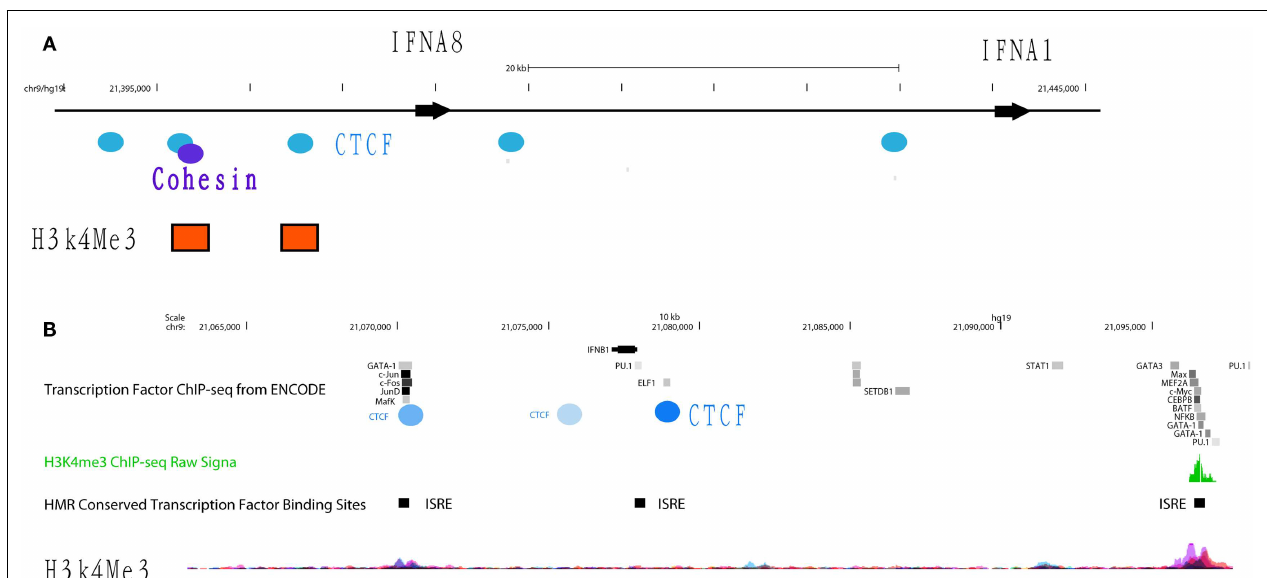
genomic region of IFNB is shown with transcription factor binding sites from the ENCODE database. Experimentally verified CTCF binding sites are shown by the blue circles, with the darker shades of blue denoting signal intensity; light blue – low intensity, dark blue – high intensity. IFN-stimulated response elements (ISRE) are labeled with black squares. Peaks showing H3K4me3 signals are